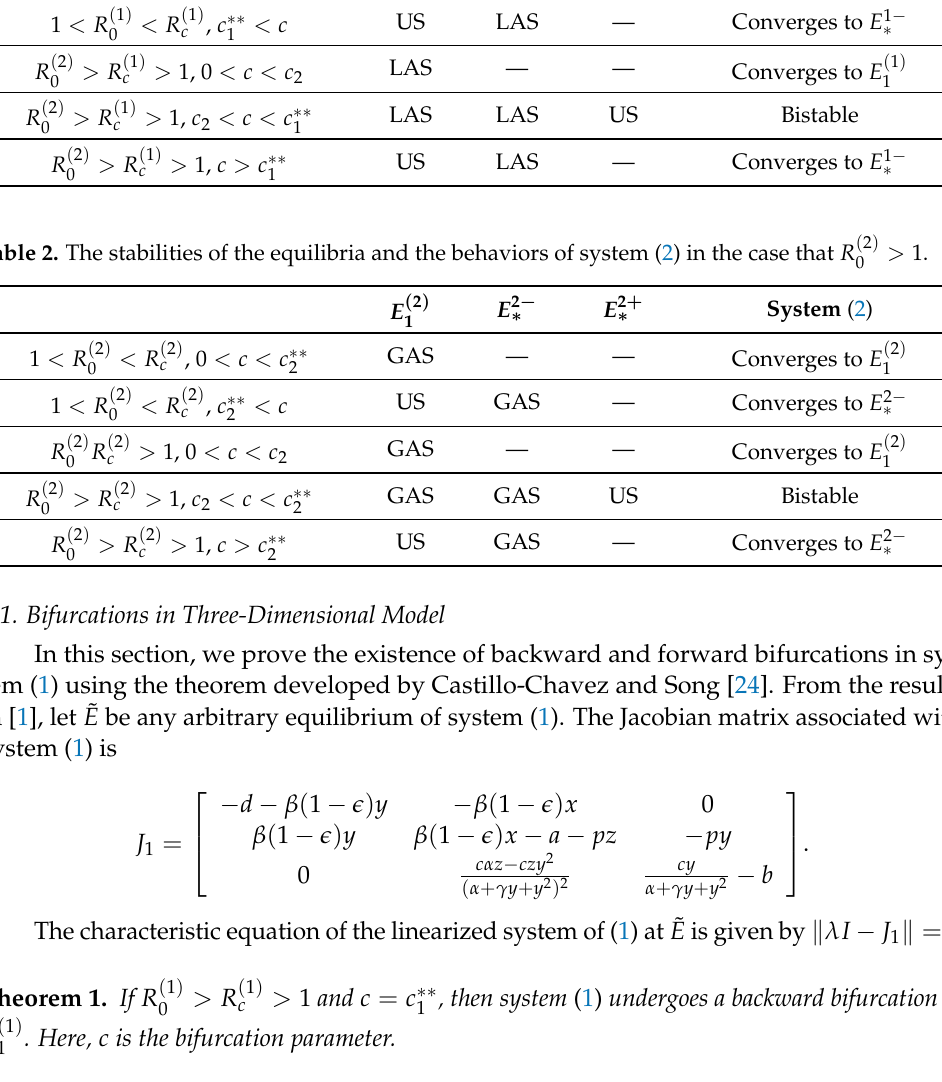
Table 1. The stabilities of the equilibria and the behaviors of system (1) in the case that R ( 1 ) E 1 − ∗ E 1 + ∗ System (1) E 1 ( 1 ) LAS — — Converges to E ( 1 ) < R ( 1 ) < c < c ∗∗ 1 < R c , 0 1 0 US LAS — Converges to E 1 − ∗ LAS — — Converges to E ( 1 )